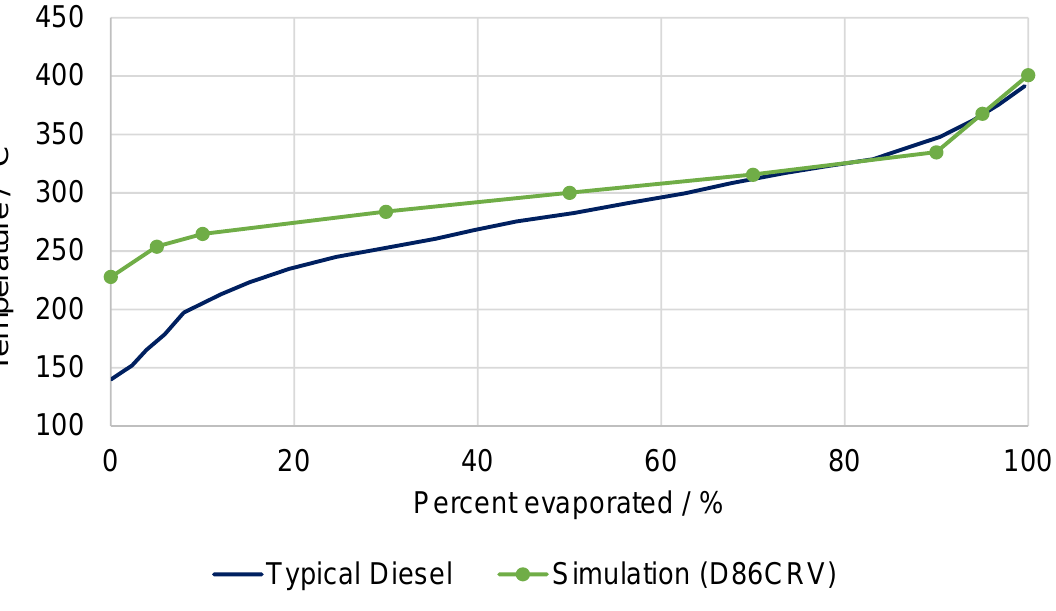
Figure 10. Boiling curves of diesel in comparison (boiling curve of “typical diesel fuel” according to Bacha et al. [4]).